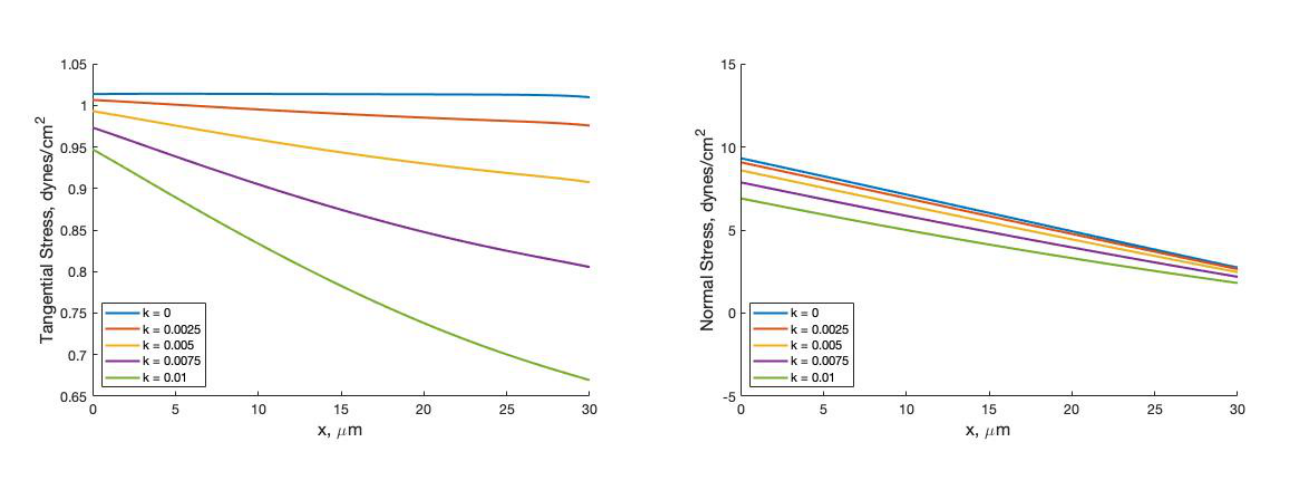
Figure 11. Tangential forces ( left ) and normal forces ( right ) on the vessel length for varied values of hydraulic conductivity k